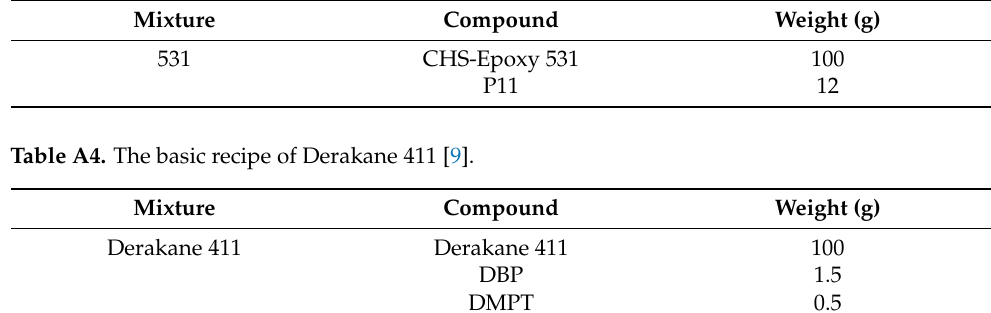
Table A3. The basic recipe of CHS Epoxy 531 [9].